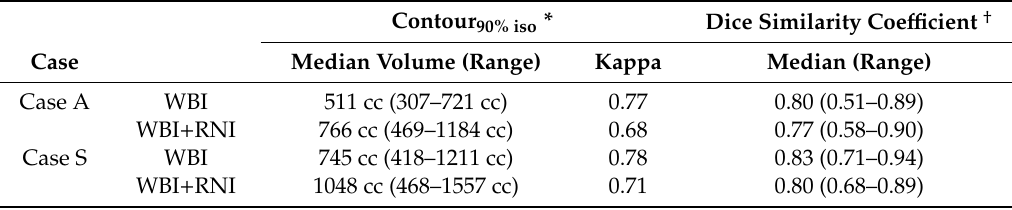
Table 1. Comparisons of dose coverage among 24 participating institutions.